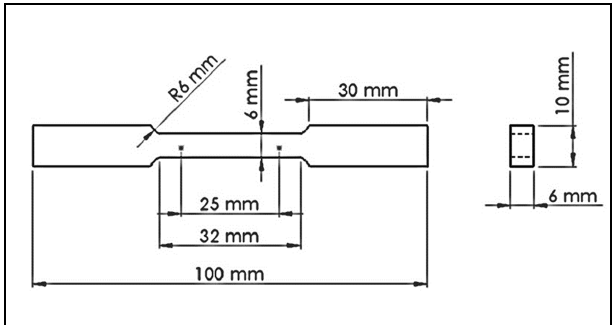
Figure 2. Schematic of the tensile test specimen.